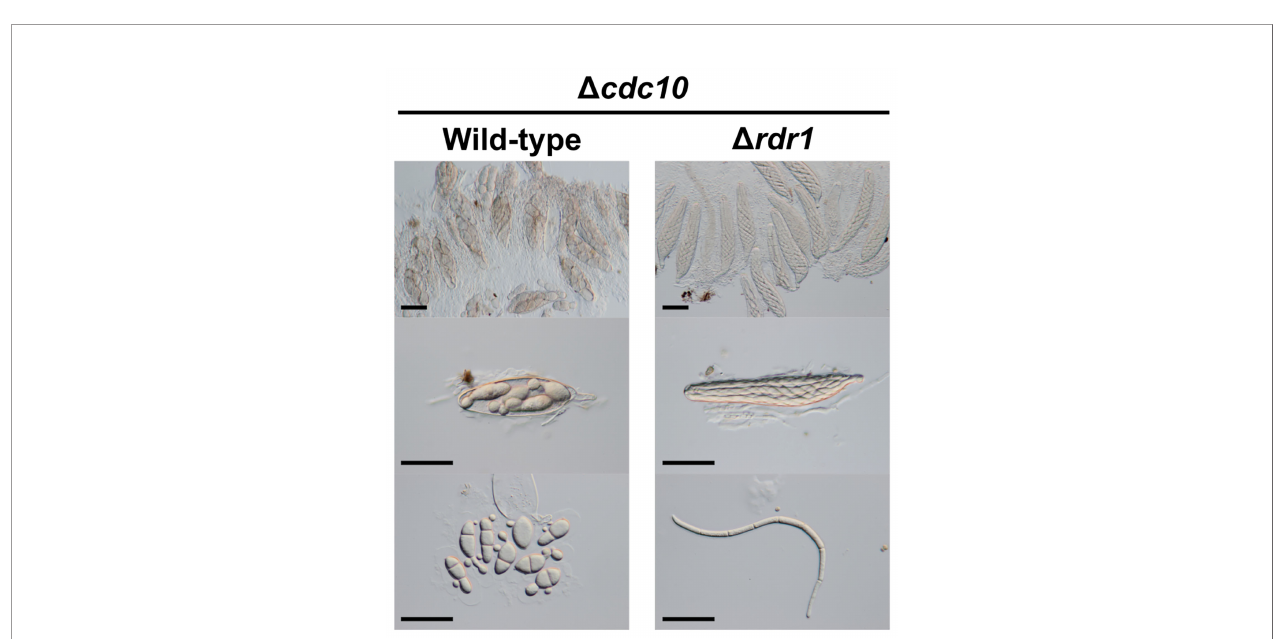
FIGURE 4 | Asci and ascospores from the cross between the D rdr1 strain and the D cdc10 strain. The D rdr1 strain was crossed with the D cdc10 strain. After 4 weeks, resulting pseudothecia were harvested and dissected to observe the asci and ascospores. Bars : 50 µm.